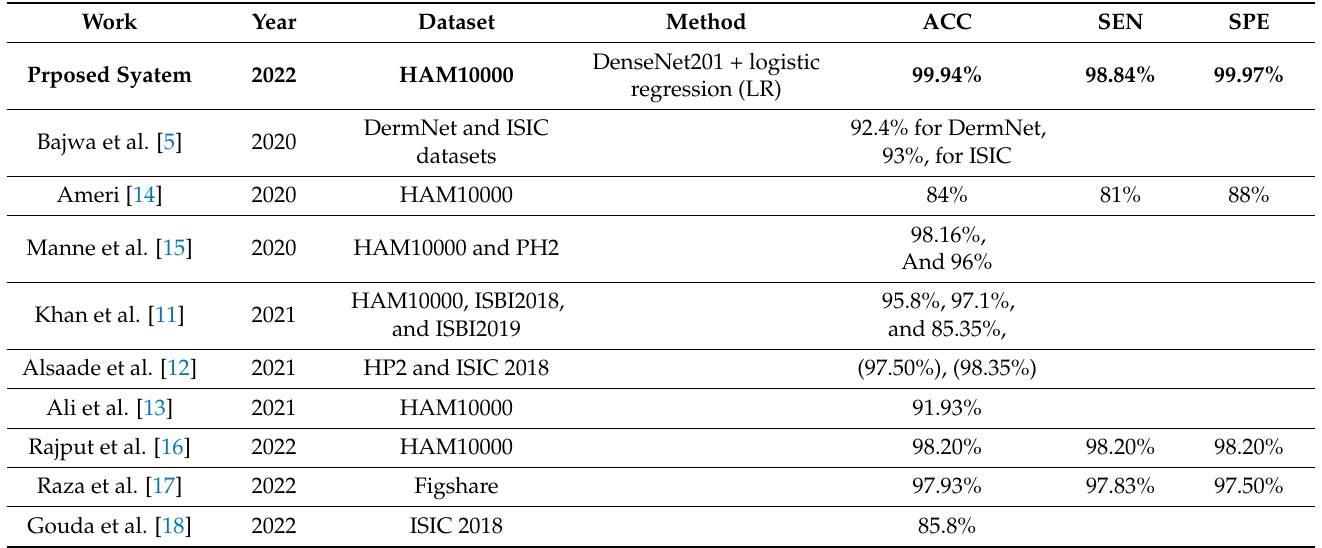
Table 11. The comparison of results of our proposed methodology with some related